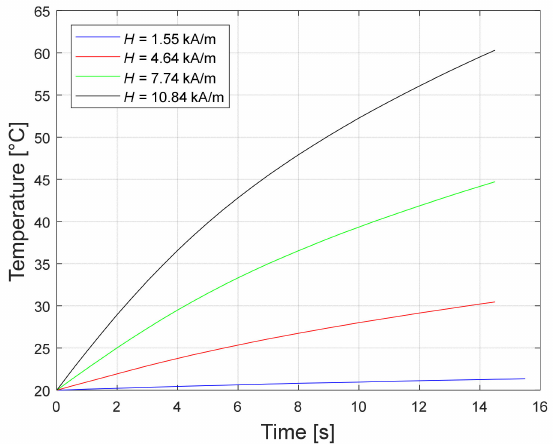
Figure 19. Calculated time–temperature curves at different magnetic field strength amplitudes with frequency being f = 281